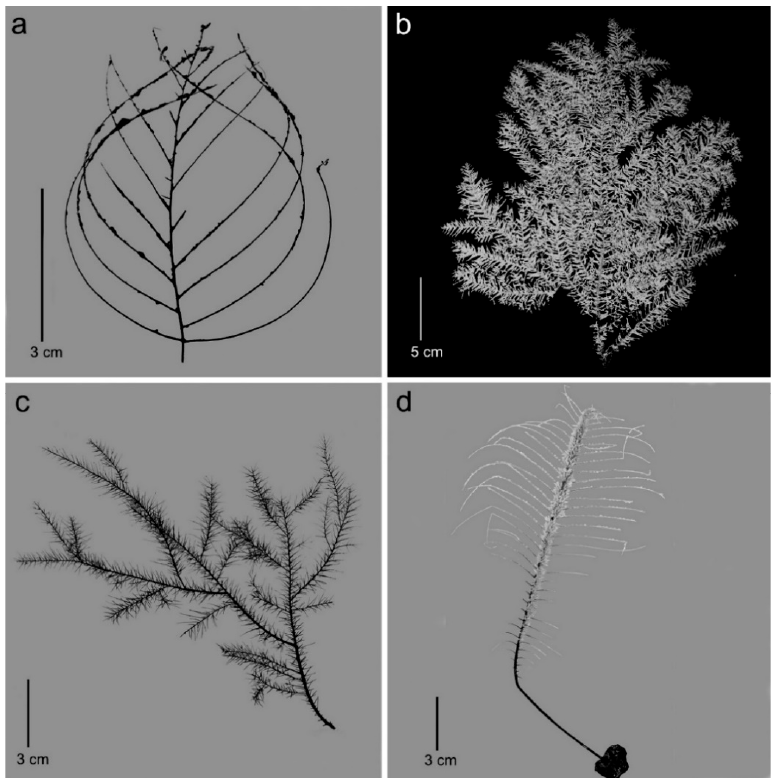
Figure 2. Select genera of the family Cladopathidae: ( a ) Abyssopathes lyra (Brook, 1889) (syntype, NHMUK 1890-4-9-22); ( b ) Trissopathes pseudotristicha Opresko, 2003 (USNM 1070975); ( c ) Chrysopathes speciosa Opresko, 2003 (paratype, USNM 92520); ( d ) Heteropathes pacifica (Opresko, 2005) (holotype, USNM 1070758).